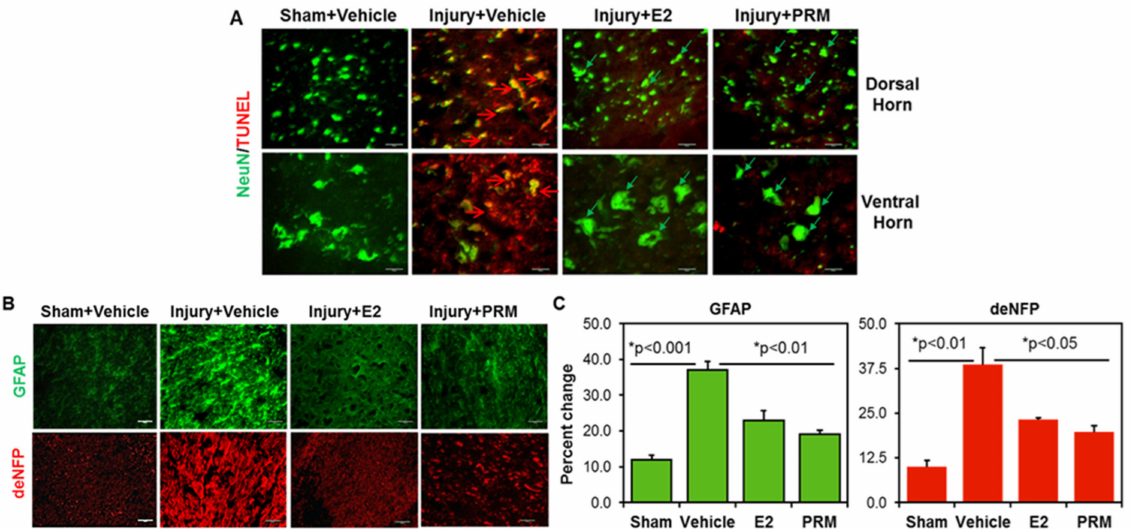
Figure 4. PRM decreased neuronal cell death and axon/myelin damage at day 7 following SCI. ( A ) Neural cell death was remarkably detected in vehicle treated injured rats as determined by double immunofluorescence staining using NeuN (neuron marker, green) and TUNEL (cell death marker, red). TUNEL positive cells are present in dorsal and ventral regions of injured spinal cords from vehicle treated groups as indicated by red arrows in the merged image (yellow). (Magnification, 200 × , n = 4–6). PRM treatment markedly reversed neuron death as compared to vehicle treatment (green arrows). E2 treatment was used a positive control. ( B , C ) Immunohistochemical analysis of SCI tissues with astroglial marker GFAP showed significant reduction of astroglial reactivity in PRM treated injured rats ( B , upper panel). Quantitative analysis of GFAP images by ImageJ (National Institutes of Health (NIH), Bethesda, MA, USA) showed that the effect of PRM on reducing astrogliosis was similar to that observed in E2-treated rats and was used as a positive control ( C , left panel). Representative immunofluorescent image using an antibody against GFAP (green) is shown (Magnification, 200 × , n = 4–6). Both PRM and E2 treatment reduced axonal damage at day 7 after SCI as indicated by a decrease in immunofluorescent staining of deNFP, a marker of axonal degeneration ( B , lower panel; C , right panel). Representative immunofluorescent staining image using antibody against deNFP (red) is shown (magnification, 200 × , n = 4–6). Data suggest that PRM promotes